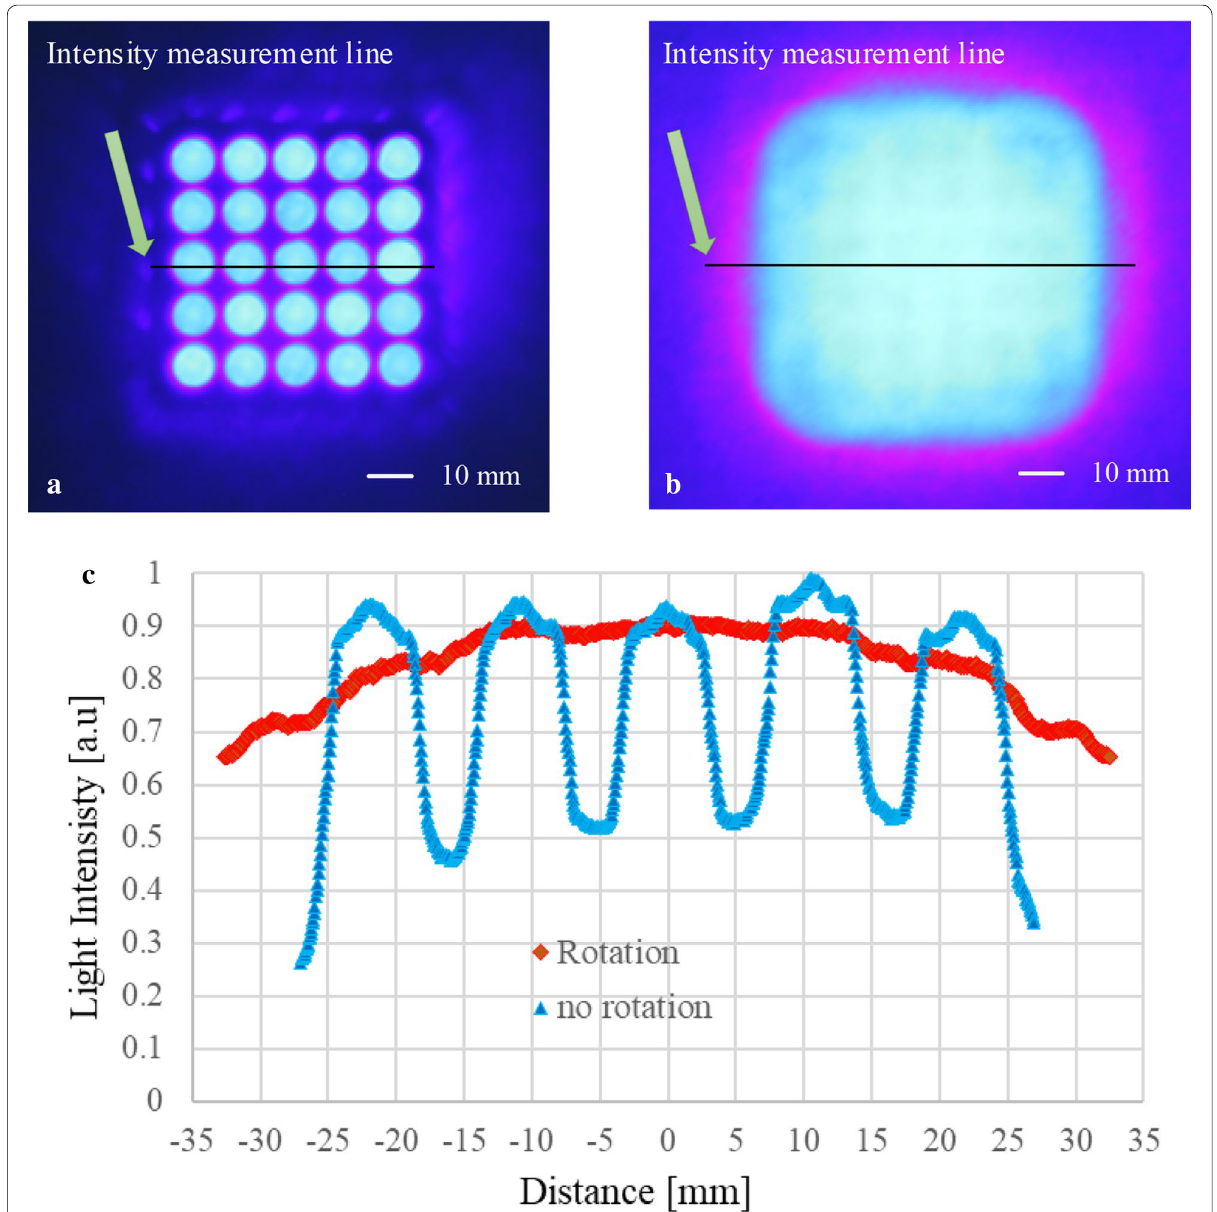
Fig. 8 Light uniformity test result: a the led light source without rotation, b with rotation, and c the light intensity distribution graph from ( a ) and ( b